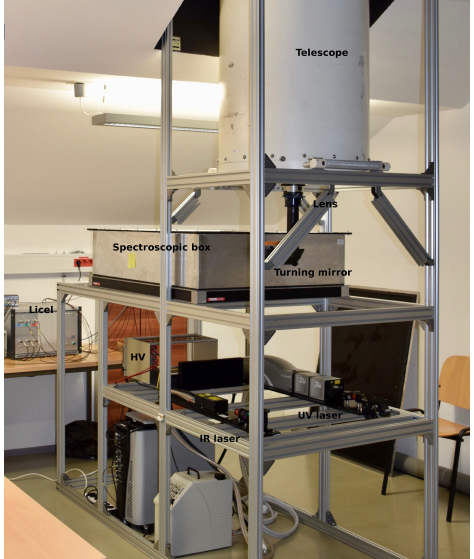
Figure 3. Assembled LiDAR system in its working environment at the Center for Atmospheric Research of the University of Nova Gorica in Ajdovšˇcina. The atmosphere is accessed through a 1-m 2 rooftop borosilicate window with > 85% light transmission in UV and IR and a remotely-controlled shutter. The telescope is mounted as close to the window as possible, leaving room for the spectroscopic filter and the transmitter